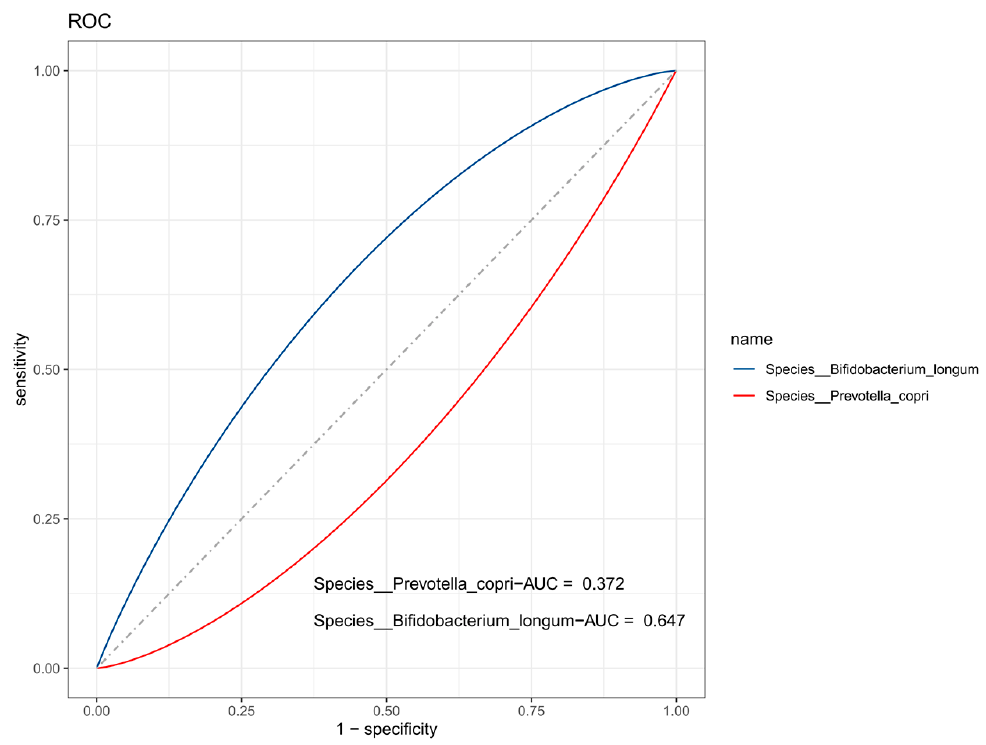
Figure 4. ROC curves for differential strain assessment of sarcopenia in older women.